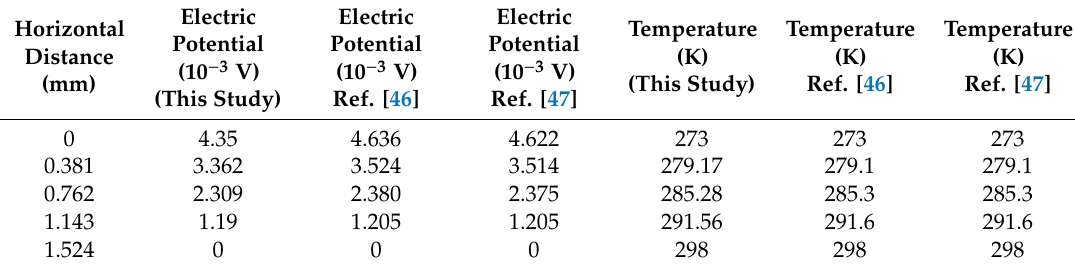
Table 6. Comparison between peridynamic results and results from references [46,47] in the case of temperature-dependent material